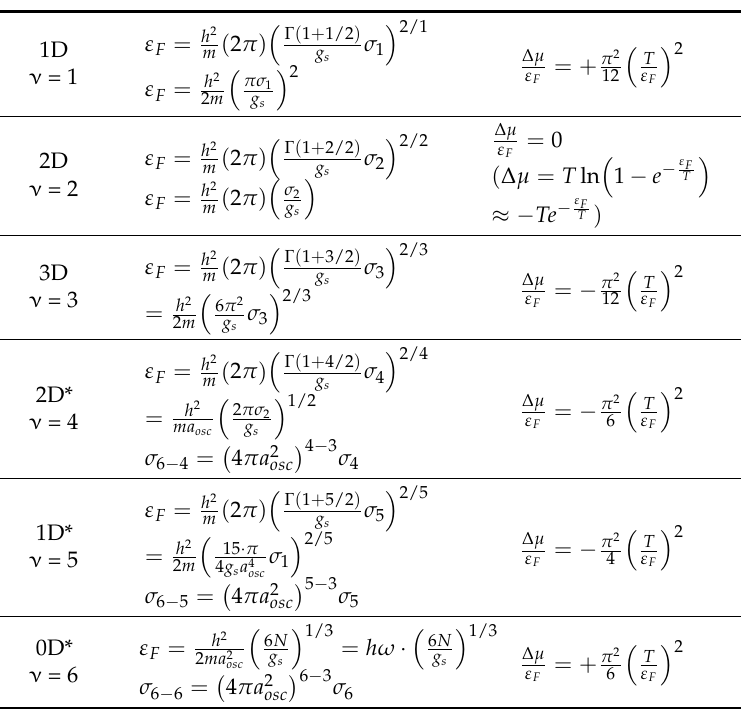
Table 1. Fermi energies and their corrections for different space